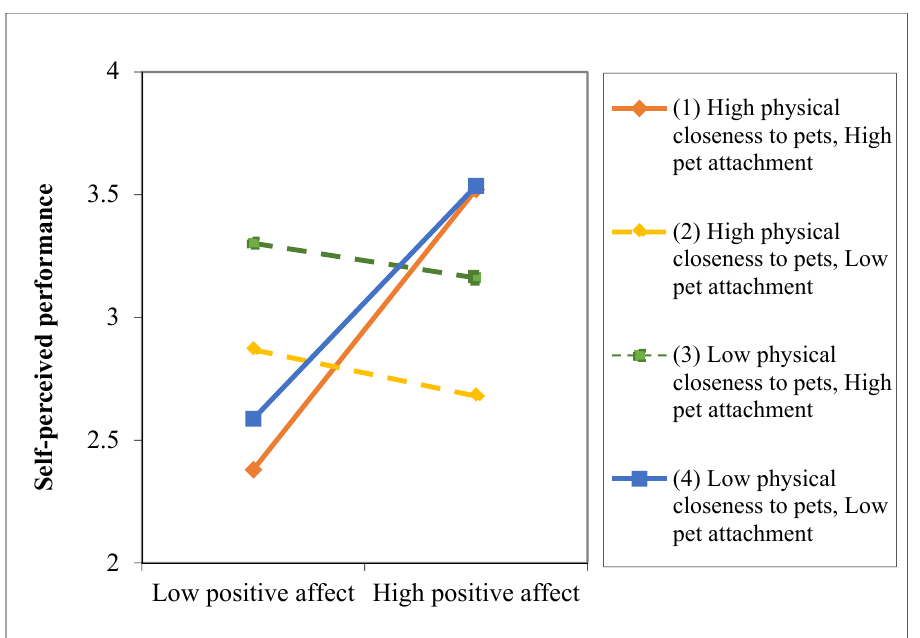
Figure 2. Indirect effect of telecommuting on self-perceived performance through positive affect conditional on pet closeness and attachment.